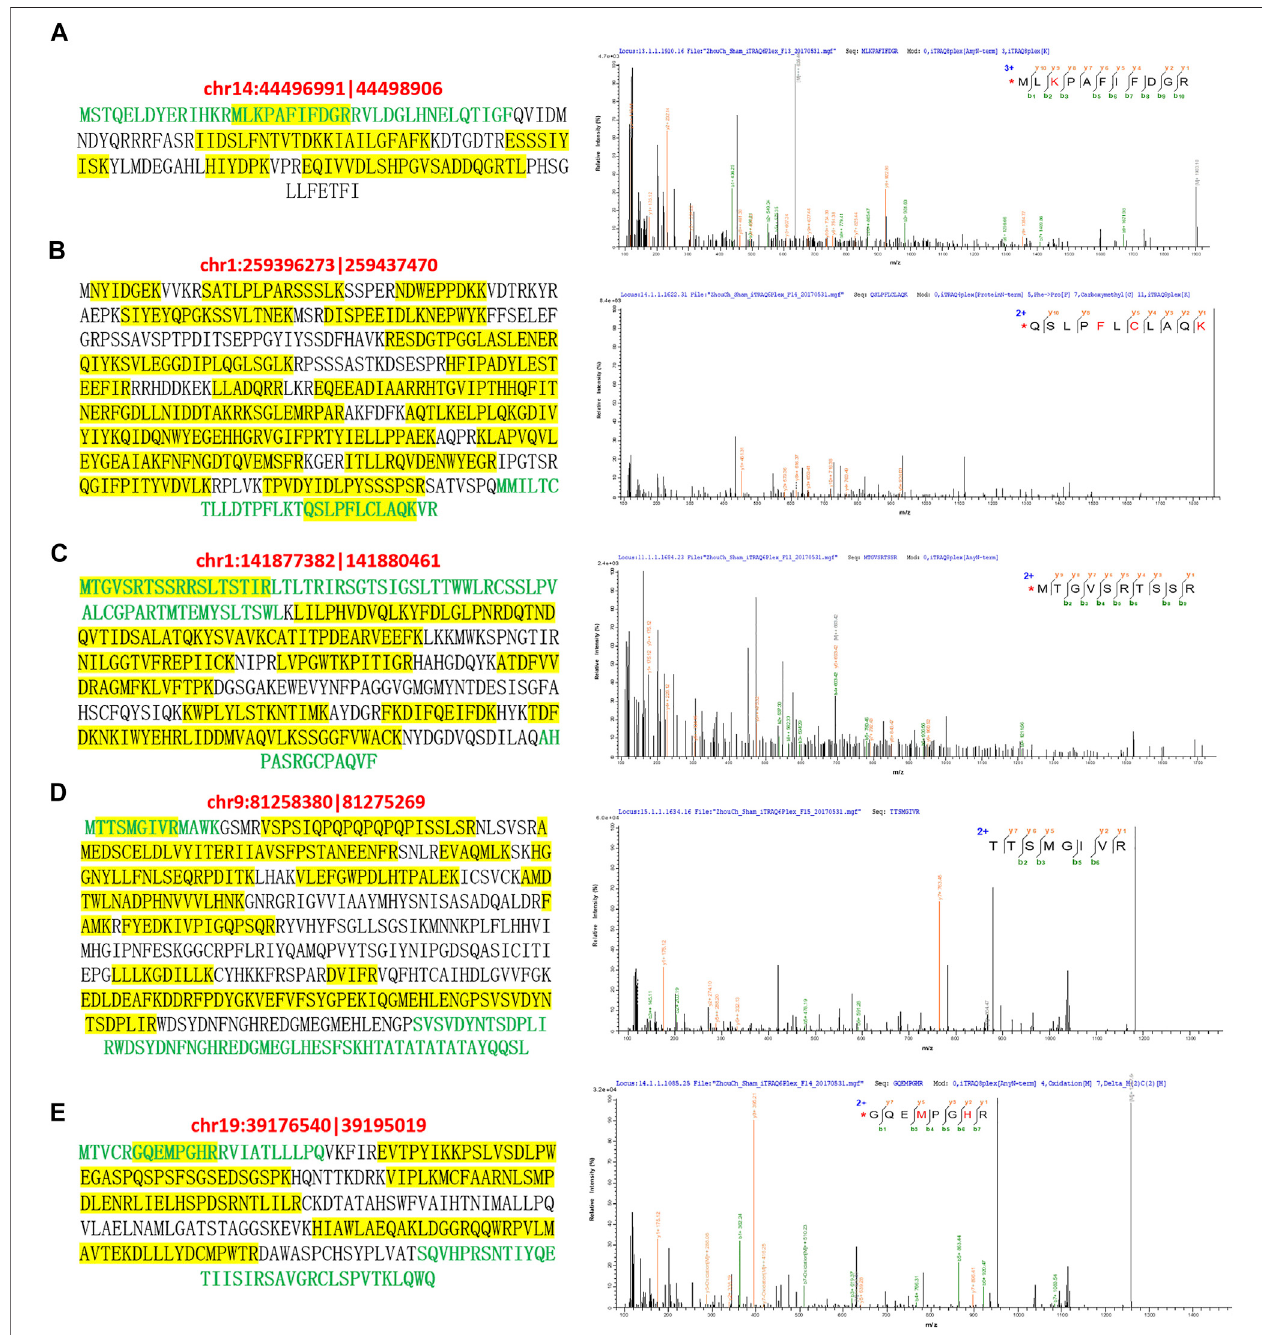
FIGURE 4 | Mass spectrometric identi fi cation of circRNA-encoded proteins in rat BOO model. The amino acid sequences of novel proteins encoded by circRNAs chr14:44496991|44498906 (A) , chr1:259396273|259437470 (B) , chr1:141877382| 141880461 (C) , chr9:81258380|81275269 (D) , and chr19:39176540| 39195019 (E) were listed in the left. Unique amino acid sequences encoded by circRNAs were shown in green, and peptides identi fi ed by mass spectrometry were highlighted by yellow background. The mass spectrometric identi fi cation of unique amino acid sequences in these fi ve circRNA-encoded proteins were shown in the right.